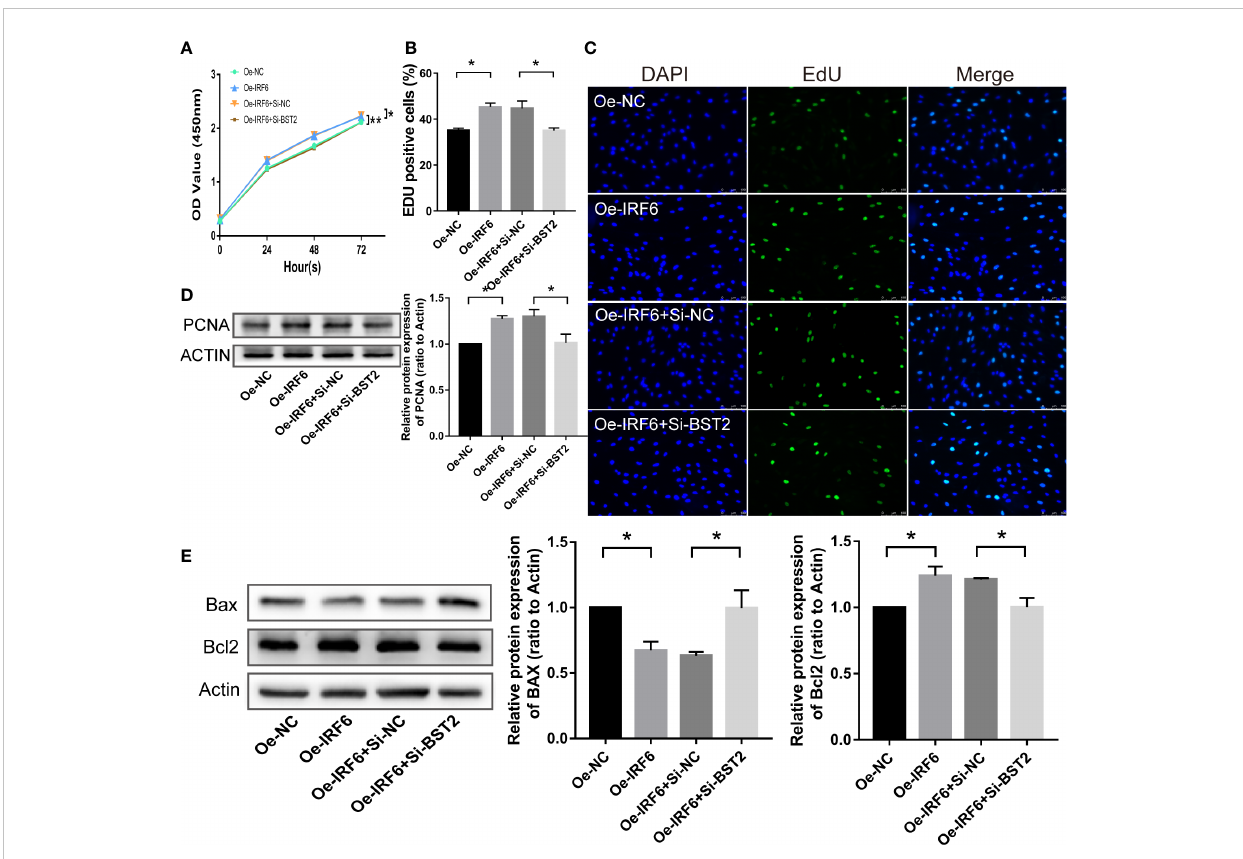
FIGURE 10 BST2 partially reversed the effects of IRF6 on the proliferation and apoptosis in EESCs. (A – C) , CCK-8 assay (A) and EdU staining assay (B, C) measured the cell proliferation ability of EESCs after transfection with Oe-IRF6 and/or Si-BST2. (D, E) , The western blot analysis examined the proliferation-related protein (D) and apoptosis-related proteins (E) after transfection with Oe-IRF6 and/or Si-BST2. *p < 0.05; **p <